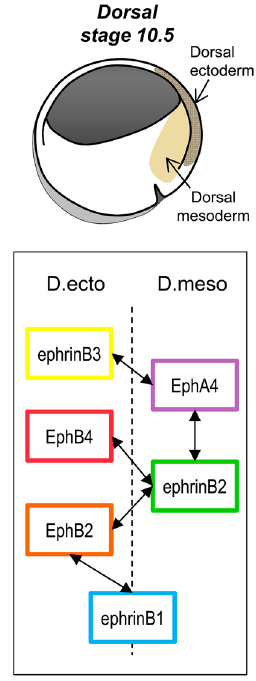
Figure 1. This study reveals how a system of multiple ephrin–Eph repulsive signals is used by embryonic cells to make the crucial decision to stay togeth- er or split into different tissues.